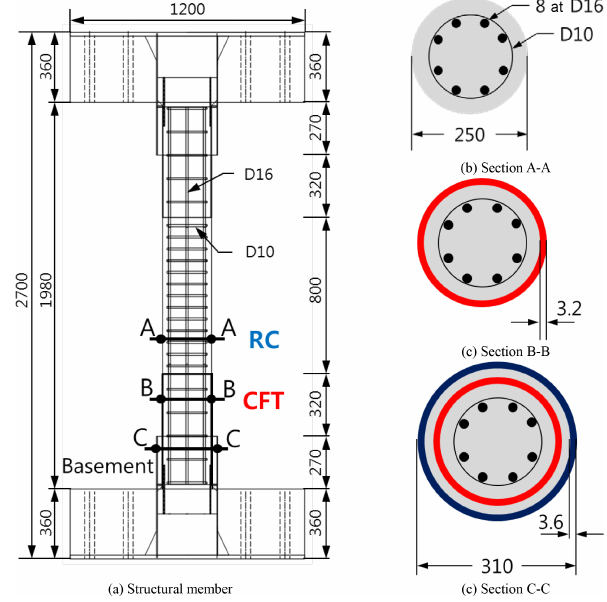
Figure 13. Configuration of test specimen (unit: